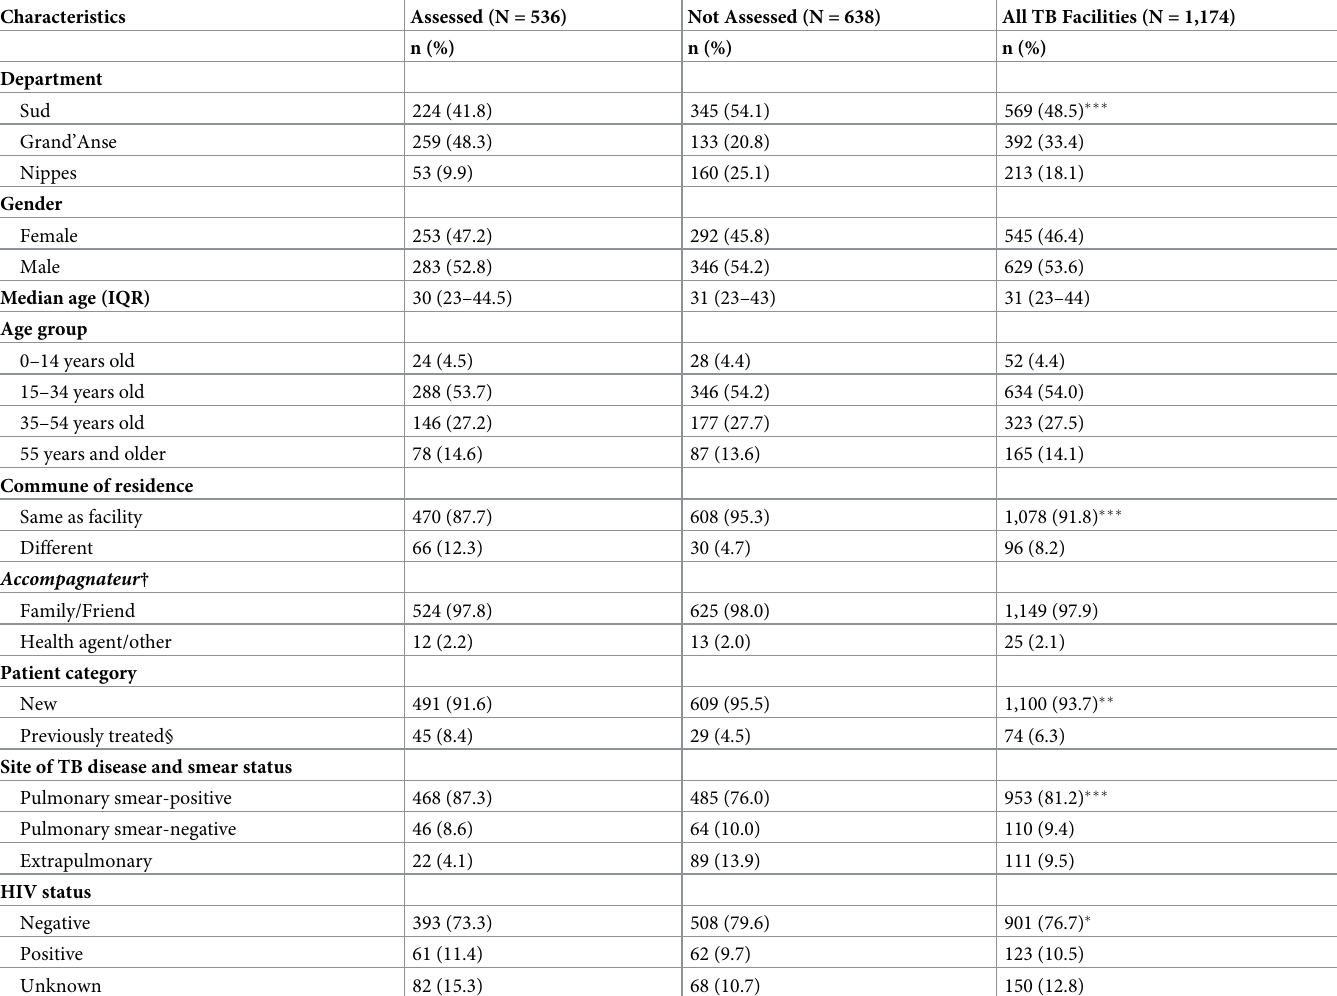
Table 1. Characteristics of the 1,174 patients receiving TB treatment in the affected departments before Hurricane Matthew.